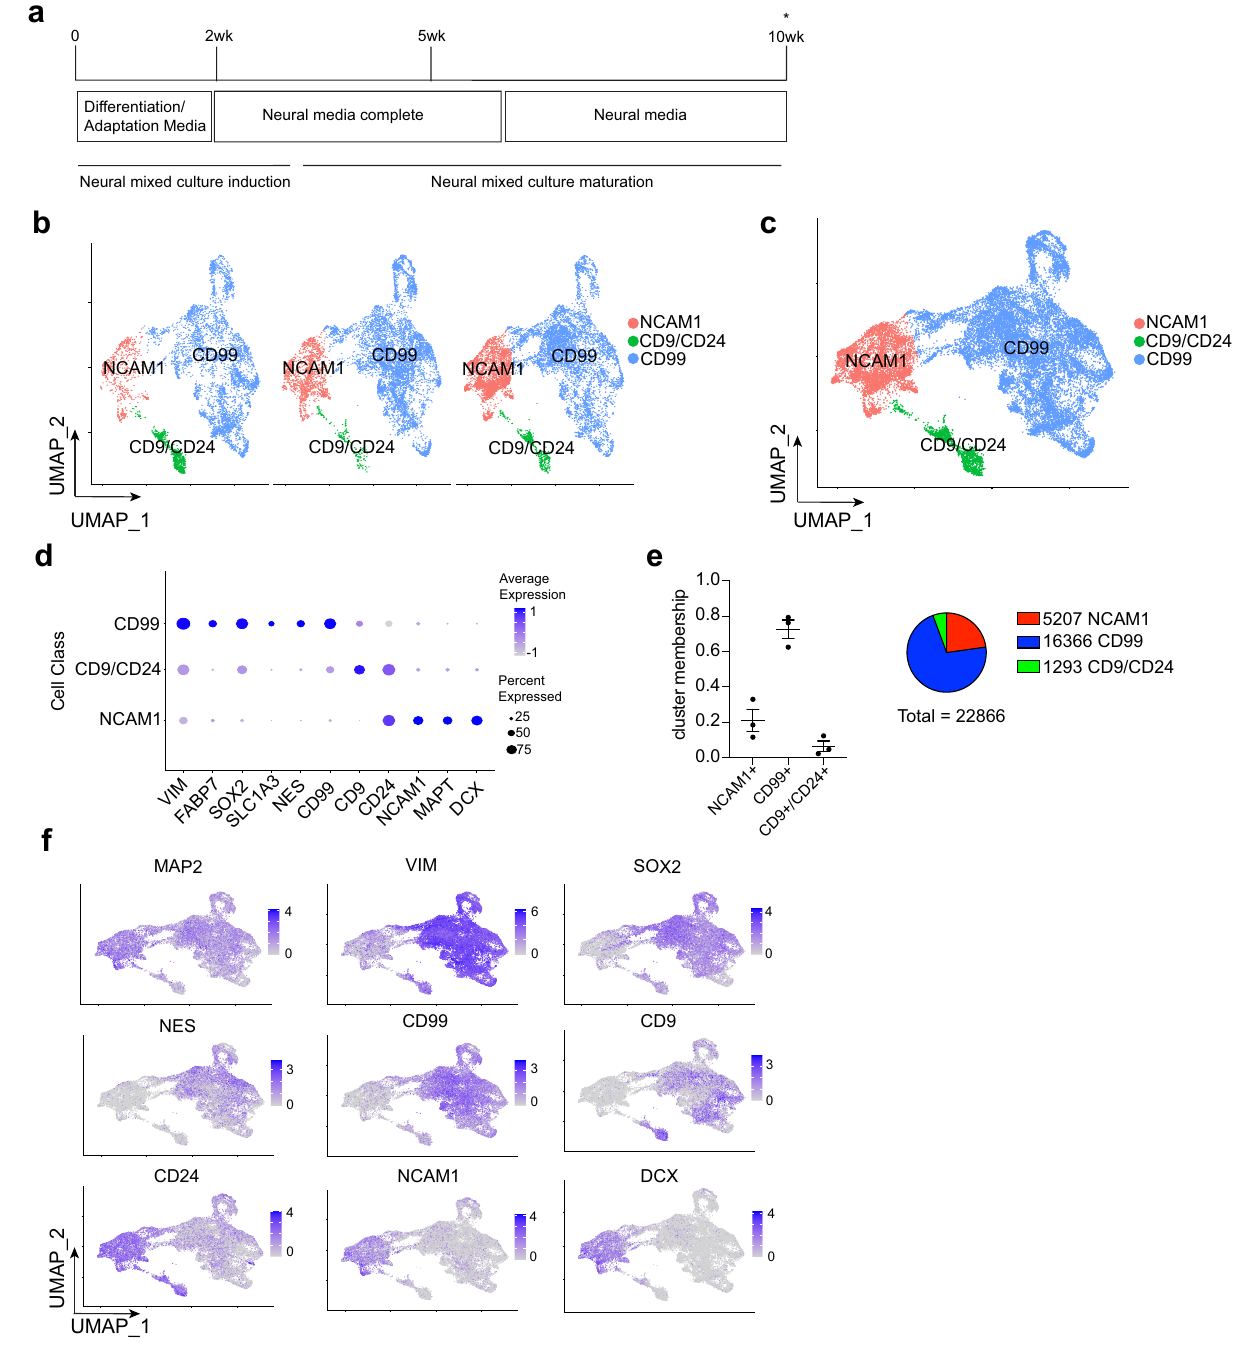
Figure 1. 10x single cell RNA sequencing of a human iPSC-derived neural mixed culture. ( a ) Neural mixed culture differentiation timeline (complete method of chemical induction described in “Materials and methods” section). *Time of harvest for 10x single cell RNA sequencing. ( b ) UMAP of integrated cell type clustering ( n = 3 independent differentiations) with cell classes defined by cell surface markers. ( c ) Merged UMAP of cell type clustering from ( b ). ( d ) Dot plot of scaled normalized RNA expression for radial glial and neuronal markers across cell classes. ( e ) Frequency of cell classes ( left ) and total numbers of cells sequenced ( right ) ( n = 3 independent differentiations, mean ± SEM). ( f ) Feature maps of normalized RNA expression plotted as UMAP for radial glial and neuronal